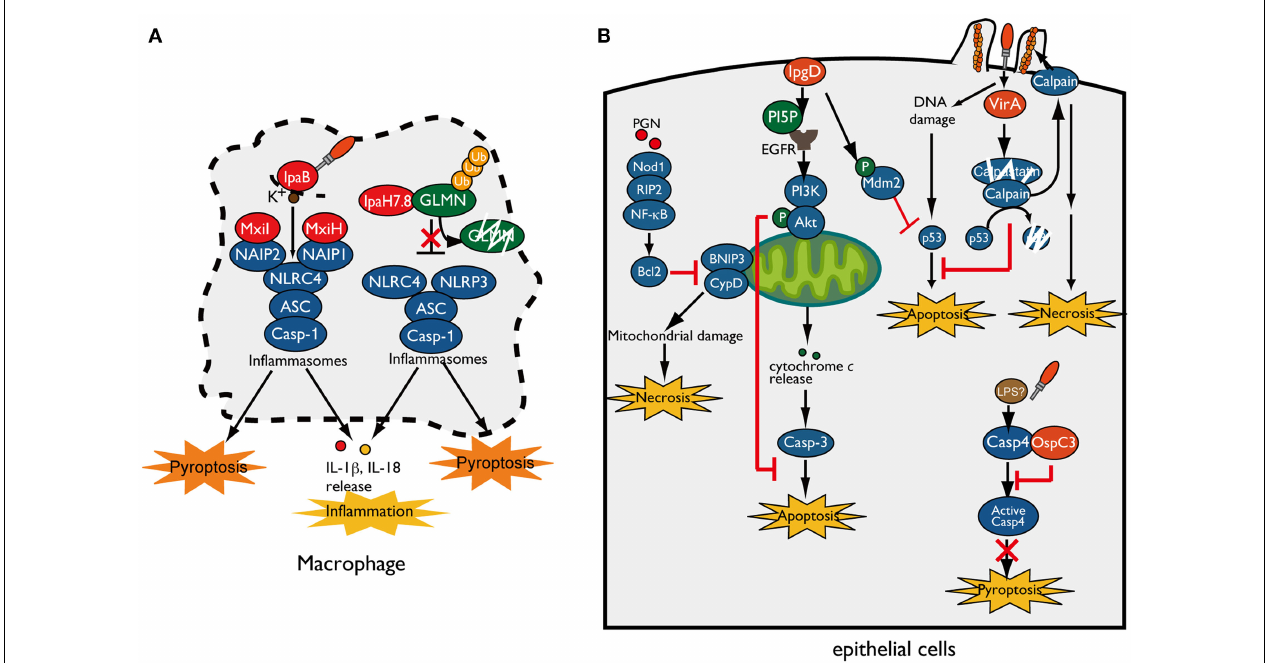
FIGURE 2 | Shigella manipulates host-cell death . (A) Shigella invasion and replication in macrophages trigger NLRC4/NLRP3-inflammasomes activation and pyroptotic cell death. The Shigella T3SS rod component MxiI and needle protein MxiH trigger NAIP2- and NAIP1-dependent NLRC4-inflammasome activation, respectively, whereas T3SS effector IpaB-mediated potassium influx triggers NLRC4-inflammasome activation and ultimately induces pyroptosis. IpaH7.8 ubiquitinates GLMN, and undergoes proteasome-dependent degradation, resulting in NLRP3/NLRC4-inflammasome activation and